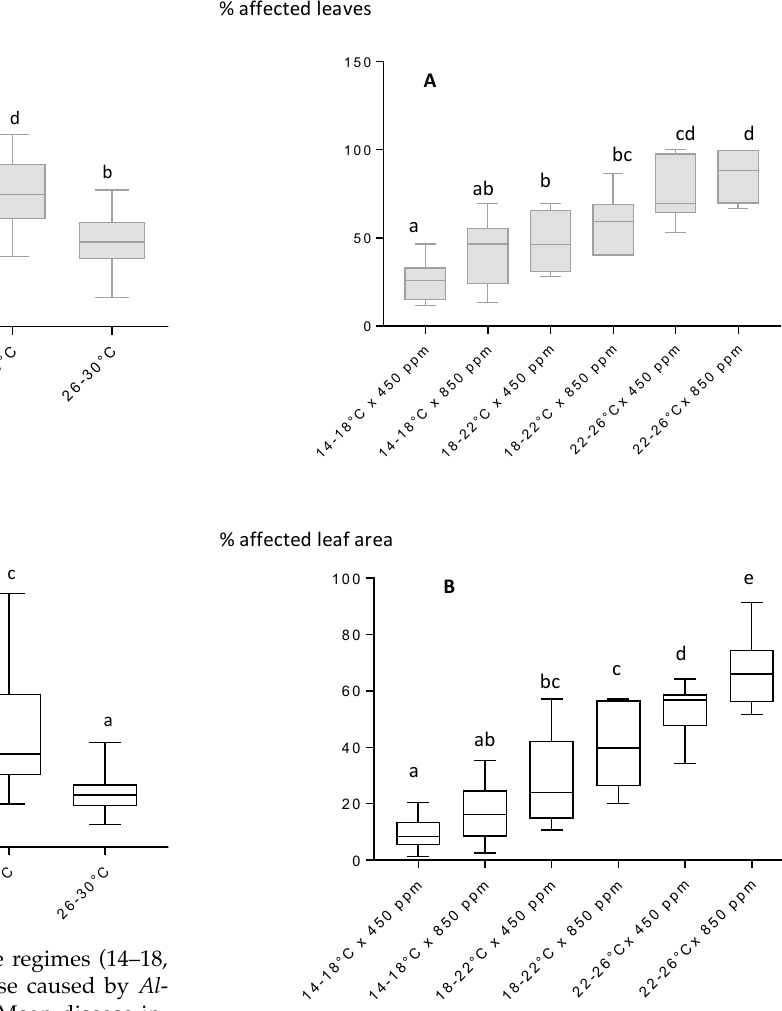
Figure 2. Effects of different CO 2 and temperature (14–18, 18–22 and 22–26°C) combinations on leaf spot, caused by Allophoma tropica on lettuce (cv. Elisa). A) Mean disease in- cidence, % of affected leaves. B) Mean disease severity, % of affected leaf area. Mean values for trials 1–3. Data ac- companied by the same letter are not significantly differ- ent, according to Tukey’s Test ( P <0.05). The boxes repre- sent the interquartile ranges (IQR) between the first and third quartiles, and the lines inside the boxes represent the median (2 nd quartile). The whiskers denote the least and greatest values within 1.56 IQR, respectively, from the first and third